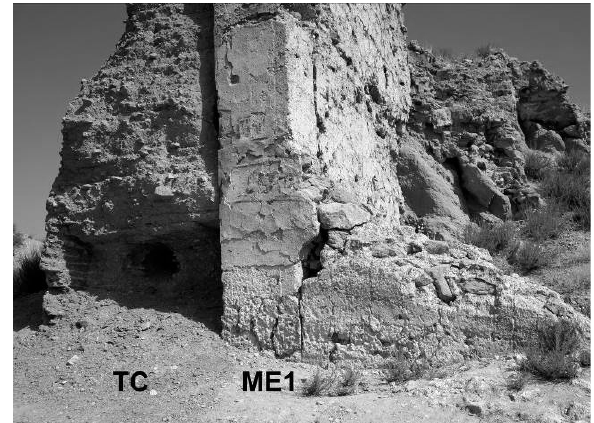
Figure 8. Tower B. Southern front. Connection between (ME1 – TC).